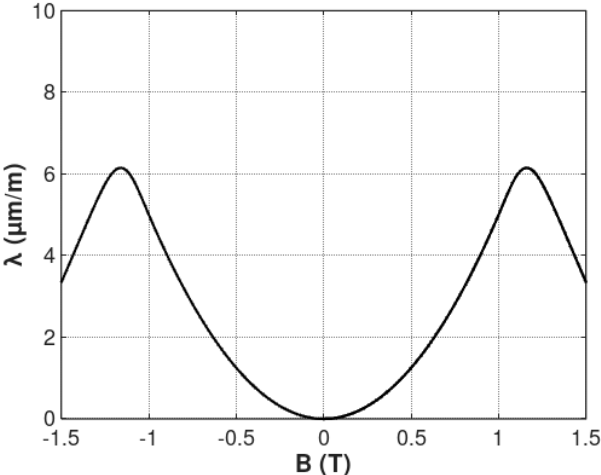
Figure 2. The flux density B dependence of anhysteretic magnetostriction λ anhyst , determined by Equation (9). Parameters: a 1 = 5 µ m